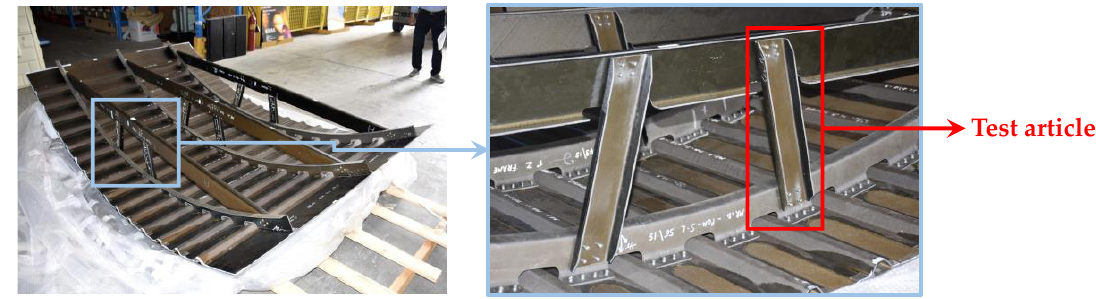
Figure 1. Location of the stanchion in a typical fuselage section.